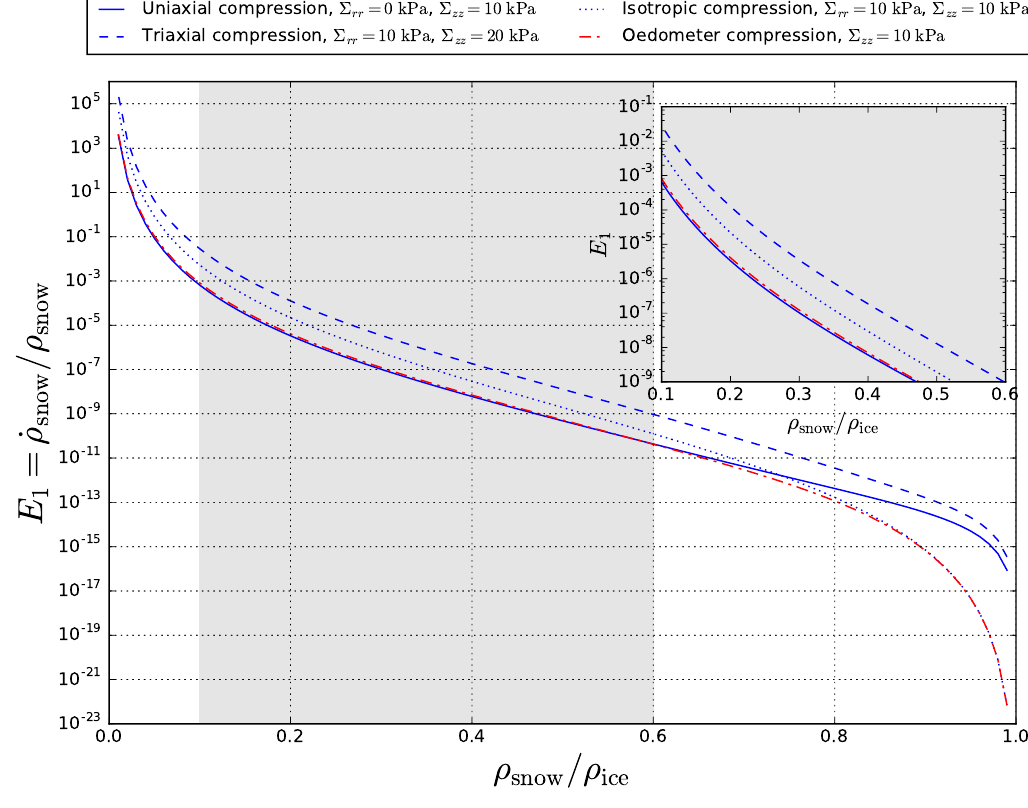
Figure 11. Predicted densification rate (for n = 4 . 5 and A = 1 . 5 × 10 − 3 MPa − n s − 1 ) with respect to snow relative density for four classical laboratory tests: an oedometric compression test (dash-dotted line), a uniaxial compression test (solid line), a triaxial compression test (dashed line) and an isotropic compression test (dotted line). The inset plot provides a zoom on the classical range of snow densities observed experimentally (gray